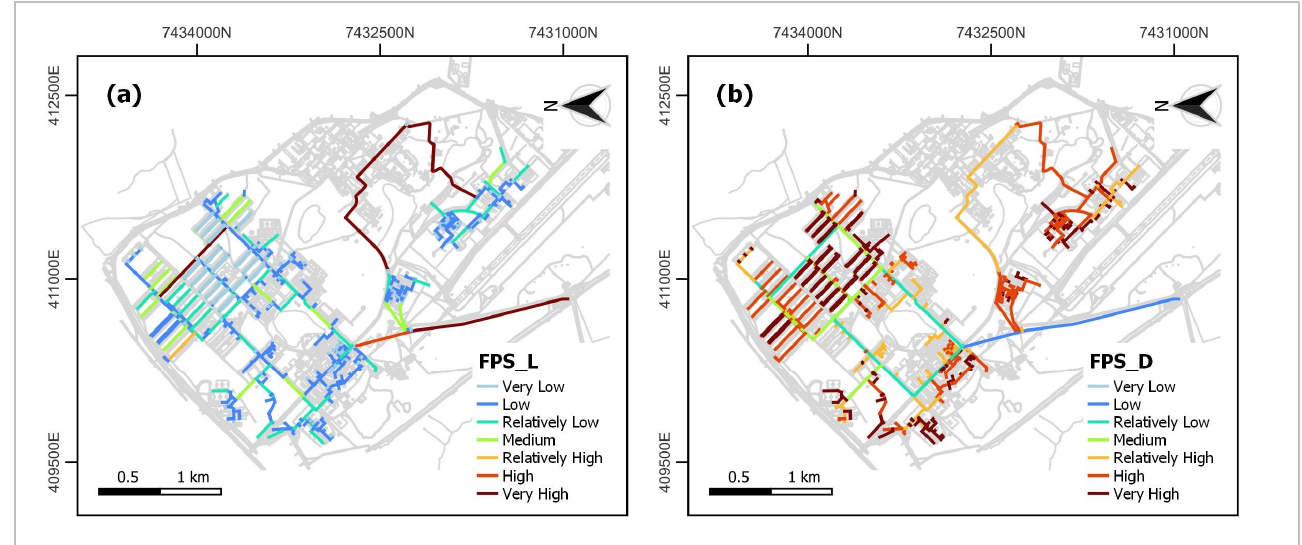
Figure 3. Risk level associated with mechanical failure in pipes: ( a ) length and ( b ) diameter.